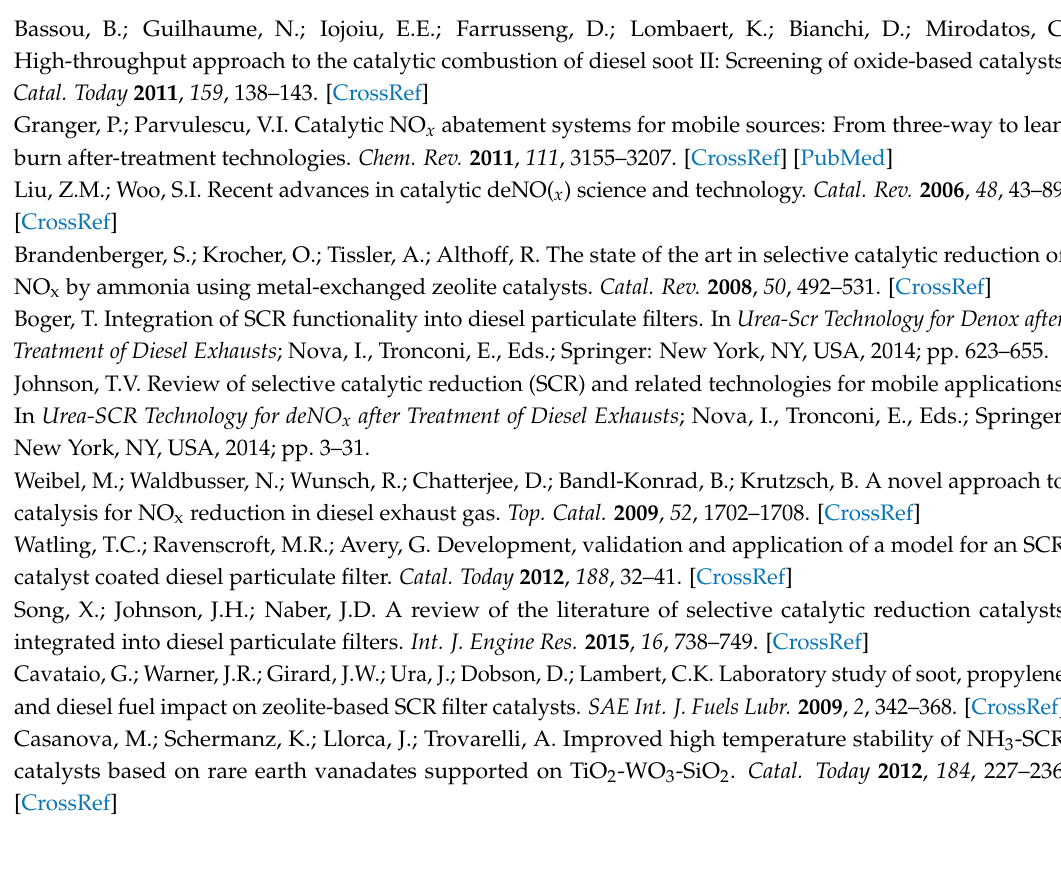
1, Figure S1: Raman spectra of 8.4 wt % FeVO 4 /Al 2 O 3 . In the blue line (grating 1800 L/mm with 5 s per accumulation) only Fe 2 O 3 and Al 2 O 3 Raman shifts are visible. Surface VO x could not be detected. In the red line Raman shifts mainly attributable to FeVO 4 and Fe 2 O 3 are shown, Figure S2: XRD patterns of (A) 50 wt % FeVO 4 and (B) 50 wt % FeErVO 4 on different supports. Figure S3: Raman spectra of 50 wt % FeVO 4 /TWS. The optical image of the sample shows that the dark spots of FeVO 4 and Fe 2 O 3 are uniformly distributed and all Raman spectra show the Raman shifts of FeVO 4 . Figure S4: Effect of FeErVO 4 loading on soot oxidation activity, Figure S5: Comparison of SCR catalytic activity of 20 mg catalytic beds of bare catalysts and with soot oxidation conducted simultaneously, Figure S6: Comparison between theoretical heating ramp and temperature measured in the catalyst bed during soot oxidation reaction on CeO 2 sample (tight contact, soot/catalyst weight ratio of 1:20), Figure S7: NH 3 oxidation carried out on single catalyst components under the following conditions: catalyst 20